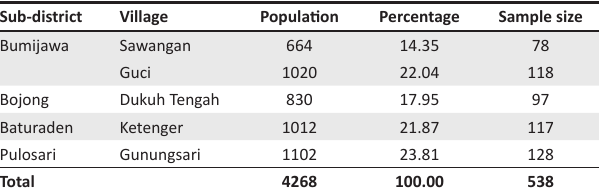
TABLE 1: Distribution of sampling of households that lived in disaster prone II area.